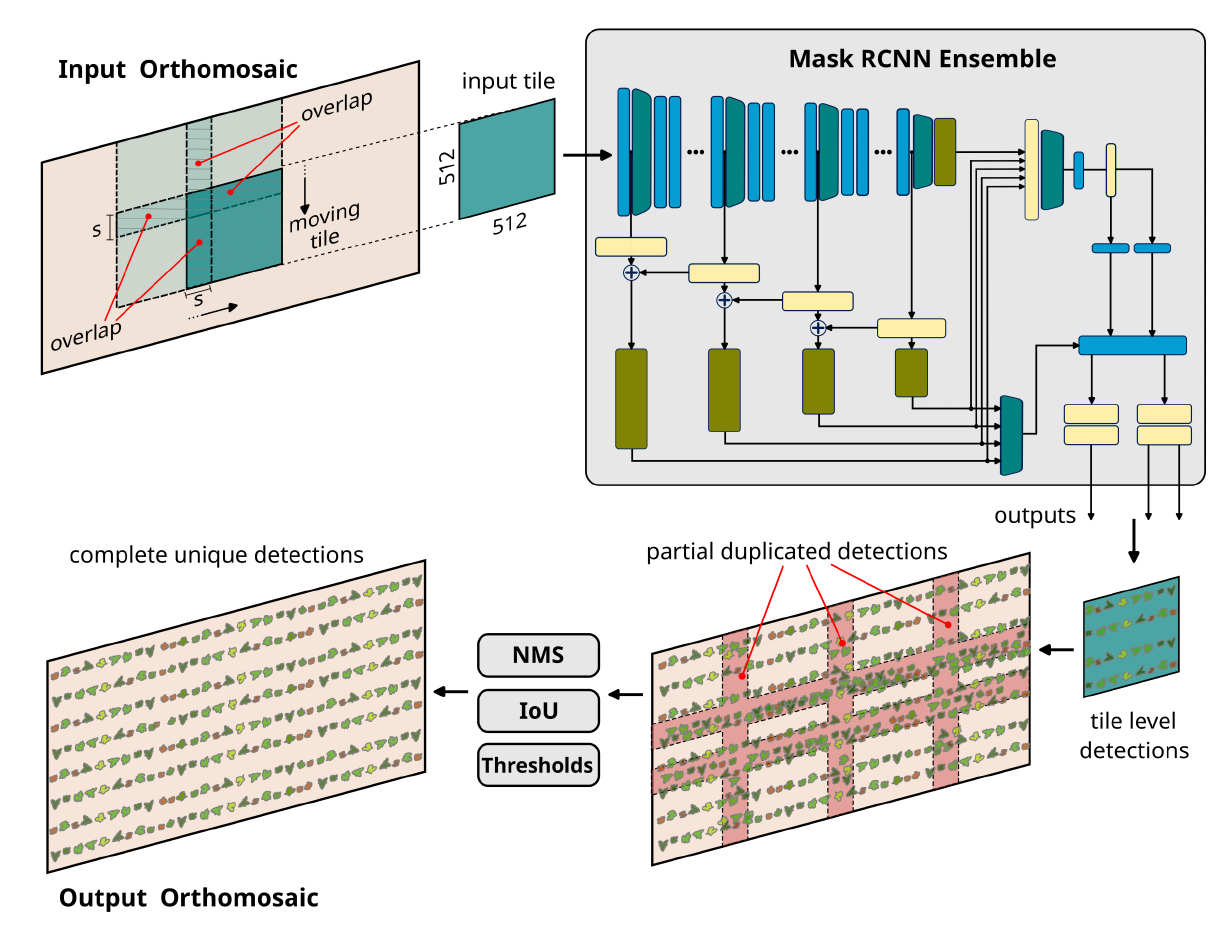
Figure 2b. The mechanism for scanning large orthomosaics by local detections on covering tiles explained above is depicted in Figure 6. Note that the phenotypic threshold filtering is only applied to detections of plants that do not appear completely on a tile, or that are duplicated because they are entirely located at the overlapping regions; all the other instance classifications are left the same as the output from the Mask RCNN.